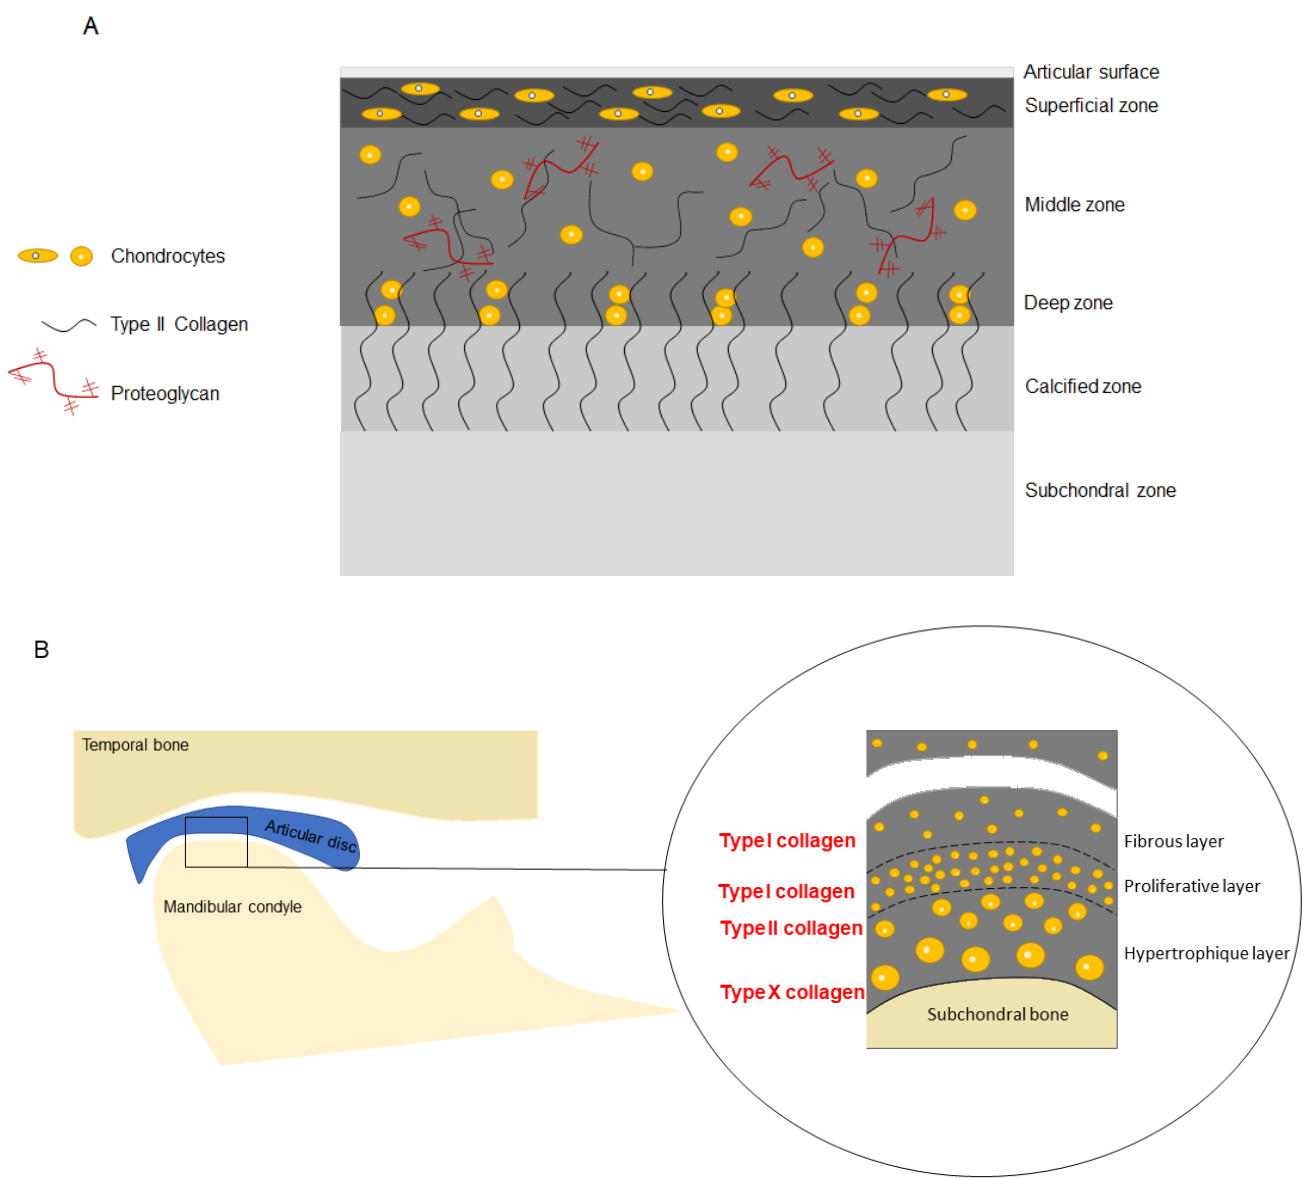
Figure 2. Composition of the hyaline cartilage ( A ) and fibrocartilage ( B